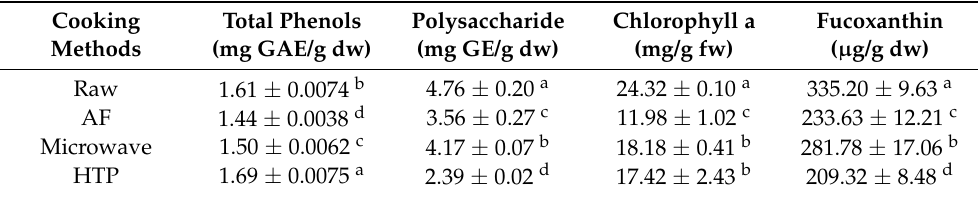
Figure 2. Representative scanning electron microscope (SEM) images of UP under different cooking methods (10 µ m length scale bar) ( a ) raw; ( b ) AF; ( c ) microwave; ( d ) HTP. Table 3. Total phenol content (TPC), polysaccharide, chlorophyll a and fucoxanthin content of different cooking